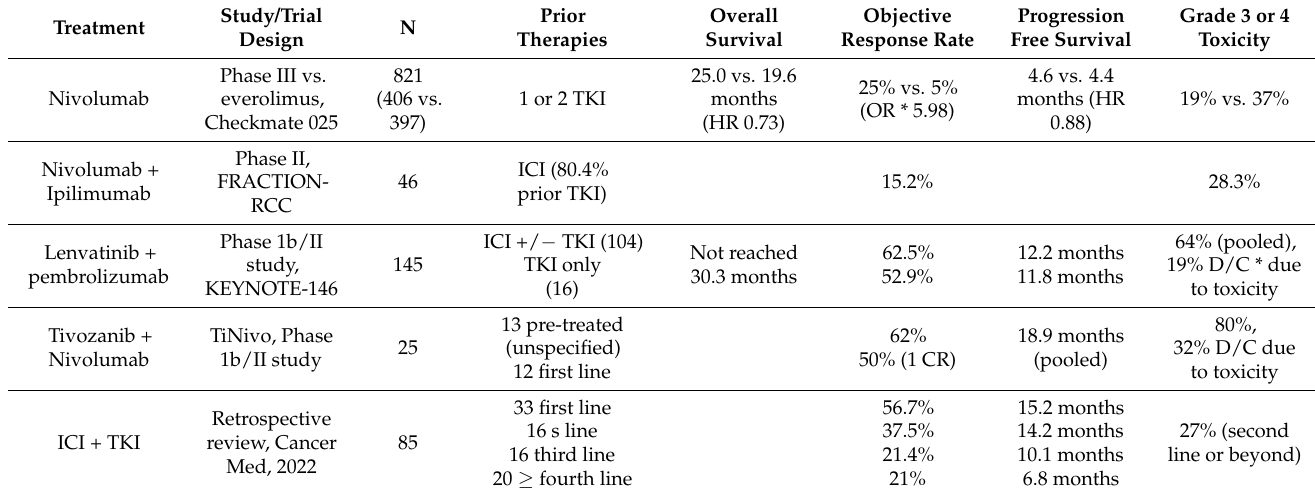
Table 2. ICI and ICI combination therapy in refractory